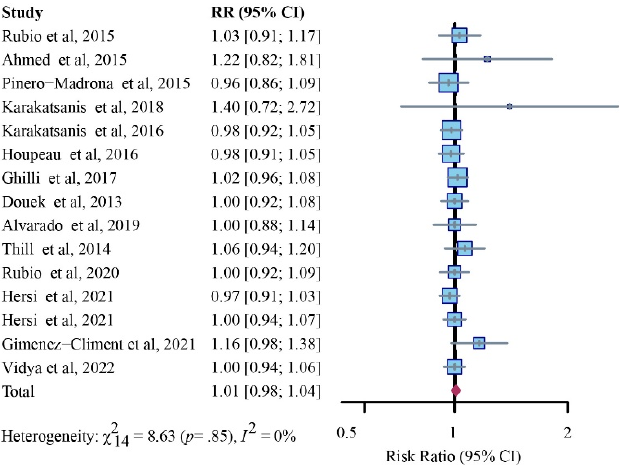
Figure 6. Relative risk (RR) analysis of identification rates for patients with positive SLNs via SPIO versus standard method (fixed-effects model).